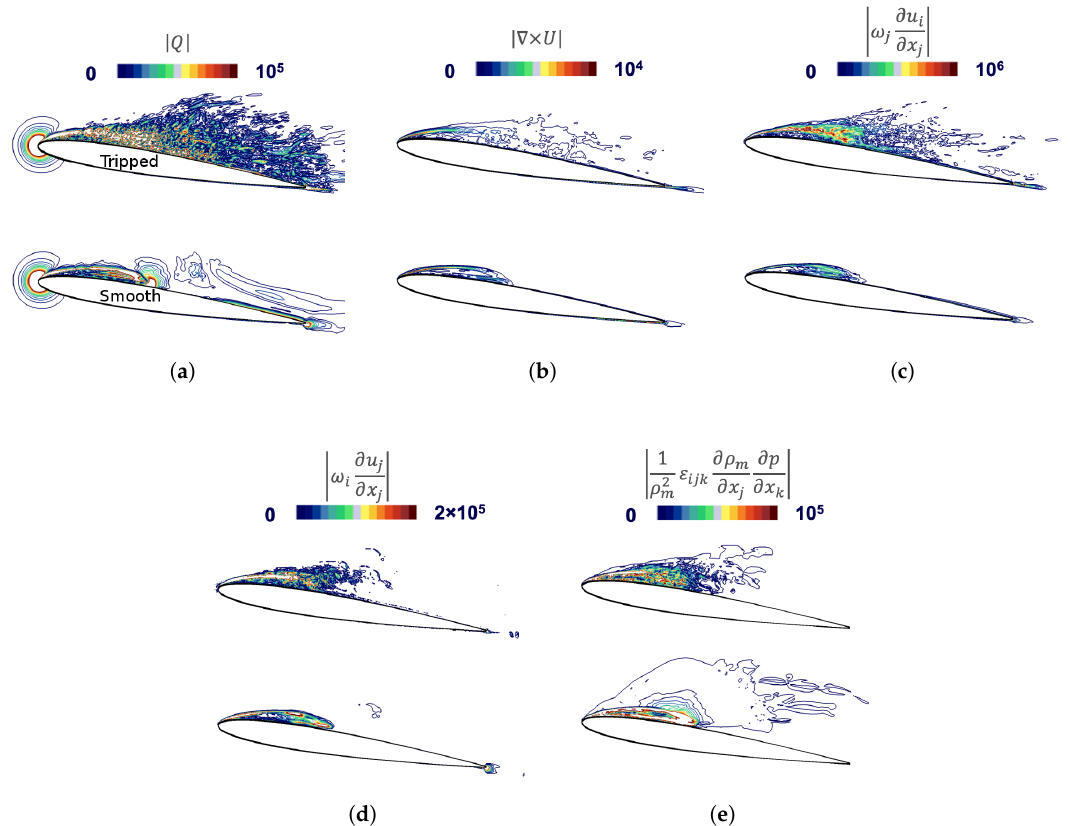
Figure 11. Distribution of vorticity properties for the smooth and tripped cases at Y = 0.5. ( a ) Magnitude of Q -criterion. ( b ) Magnitude of velocity curl. ( c ) Magnitude of stretching term. ( d ) Magnitude of dilatation term. ( e ) Magnitude of baroclinic